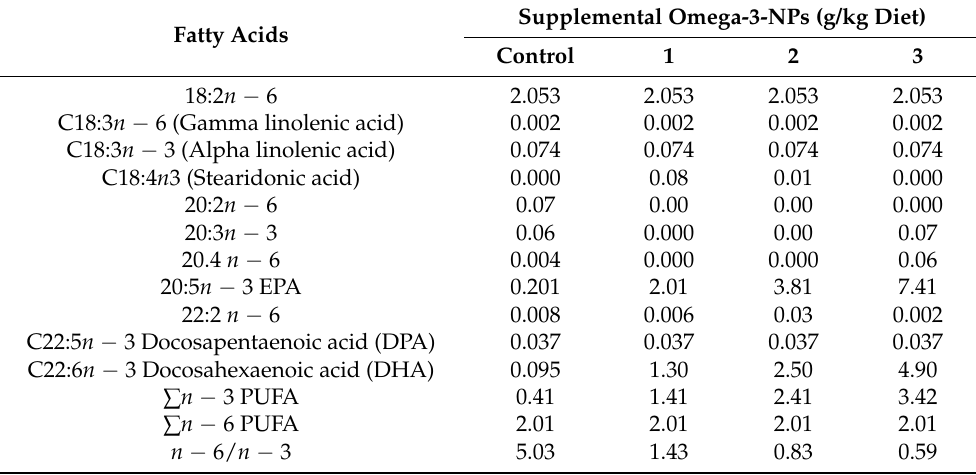
Table 2. The composition of fatty acid of the experimental diets (%). Supplemental Omega-3-NPs (g/kg Fatty Acids